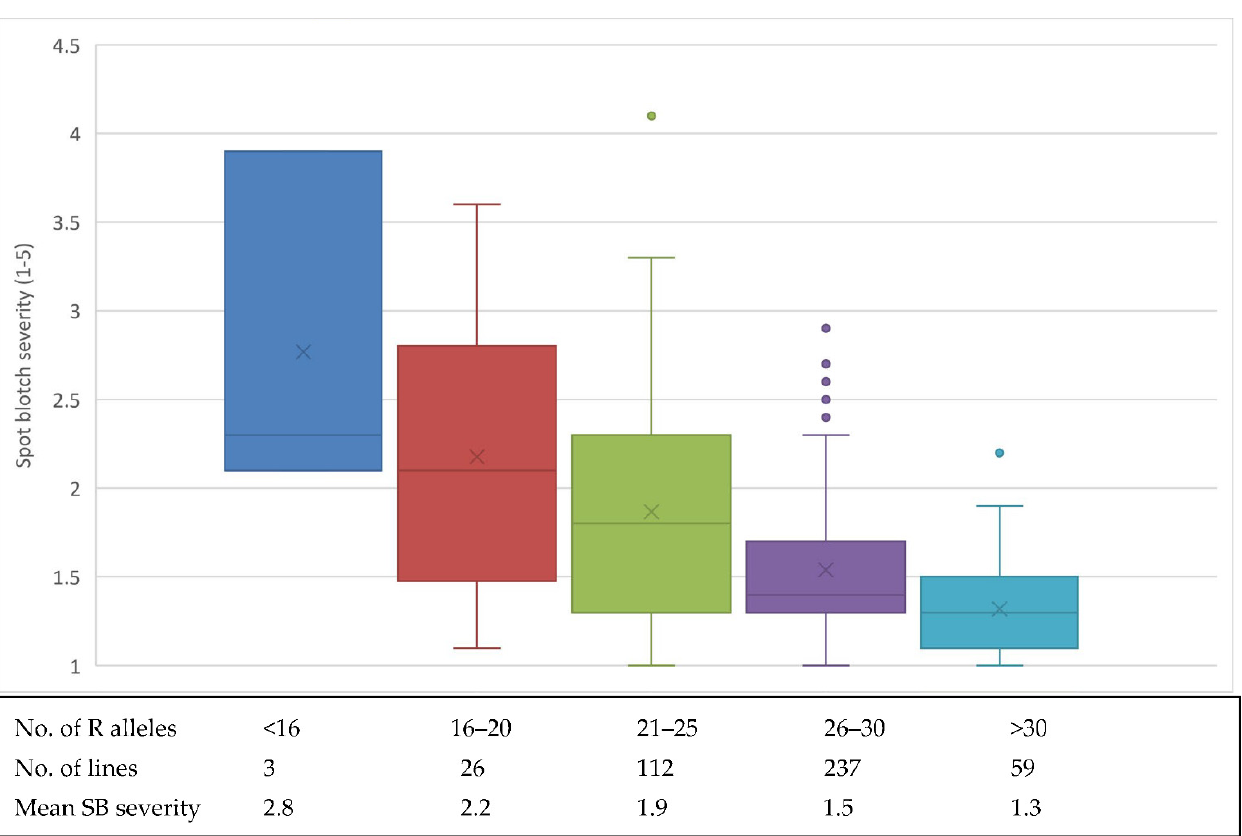
Figure 5. Boxplot showing the effects of stacking different number of resistance (R) alleles (QTL) on mean SB severity. The average severity is represented by the ‘x’ symbol and the median by the horizontal line inside.